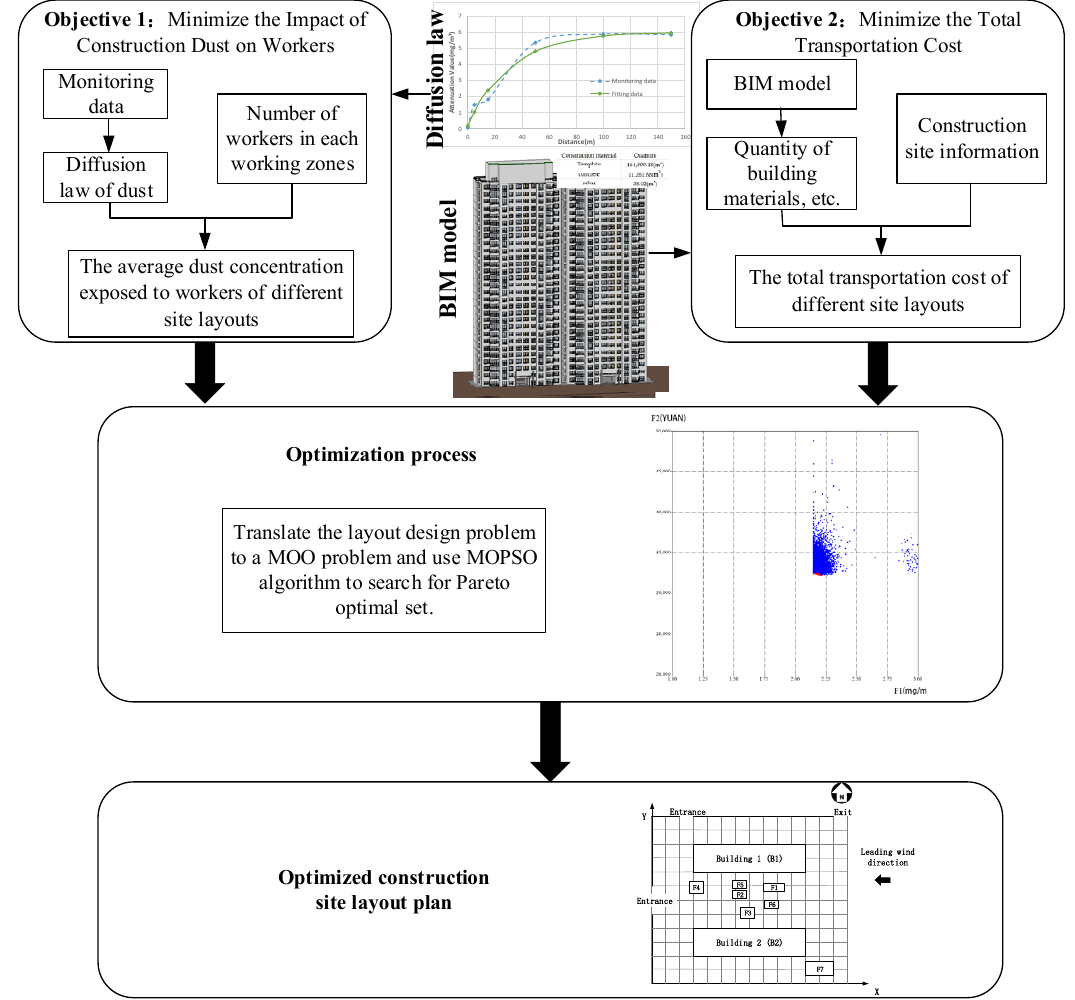
Figure 1. The framework for reducing construction dust effect by CSLP.